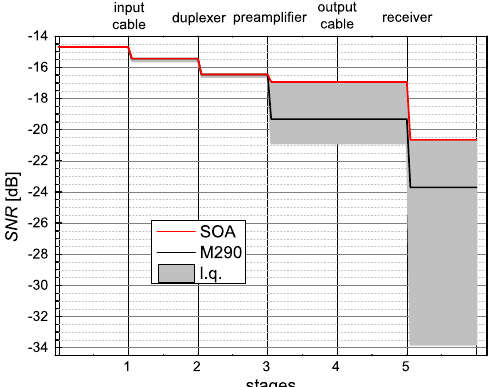
Figure 7. Calculated SNR deterioration of the weakest signal that has SNR in = − 14.7 dB along NMR receiving chain, for various conditions: existing chain with SOA (red) or M290 (black). The gray area depicts an estimated range of NMR signal’s SNR deterioration by placing low-quality (l.q.) elements in the